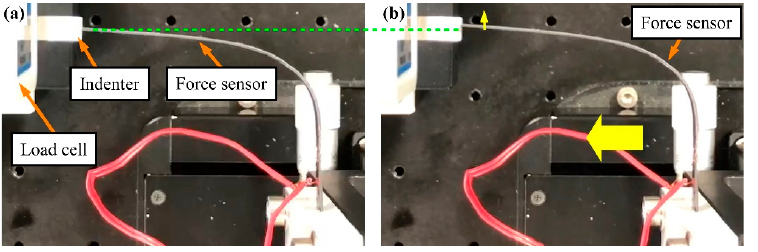
Figure 9. Movement of sensor tip (sample no. 2). ( a ) Before movement. ( b ) After 2-s movement of automatic stage. Yellow arrows show movement directions. The green dashed line shows the initial position of the sensor tip.